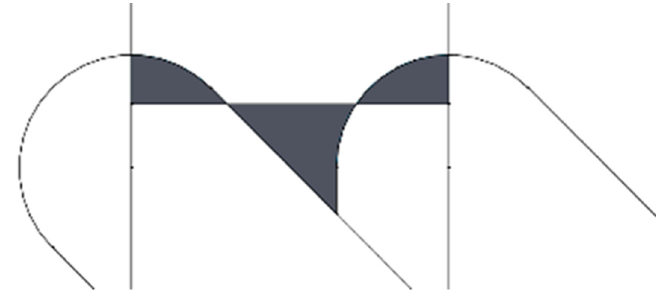
Figure 3. Profile for print orientation angle of 45°, with the areas highlighted in grey . 4. The center line of the profiles was found with Solid Works, taking into account the mean value theorem for integrals. The center line divides a profile function into two parts, so that the areas contained by the profile above and below the center line are equal (Figure 3). The first mean value theorem for integrals says that for all continuous functions in the area [a, b] a point c exists within the interval [a, b], which makes the area below the function equal to its image at point c for all the interval length, according to Equation (1).